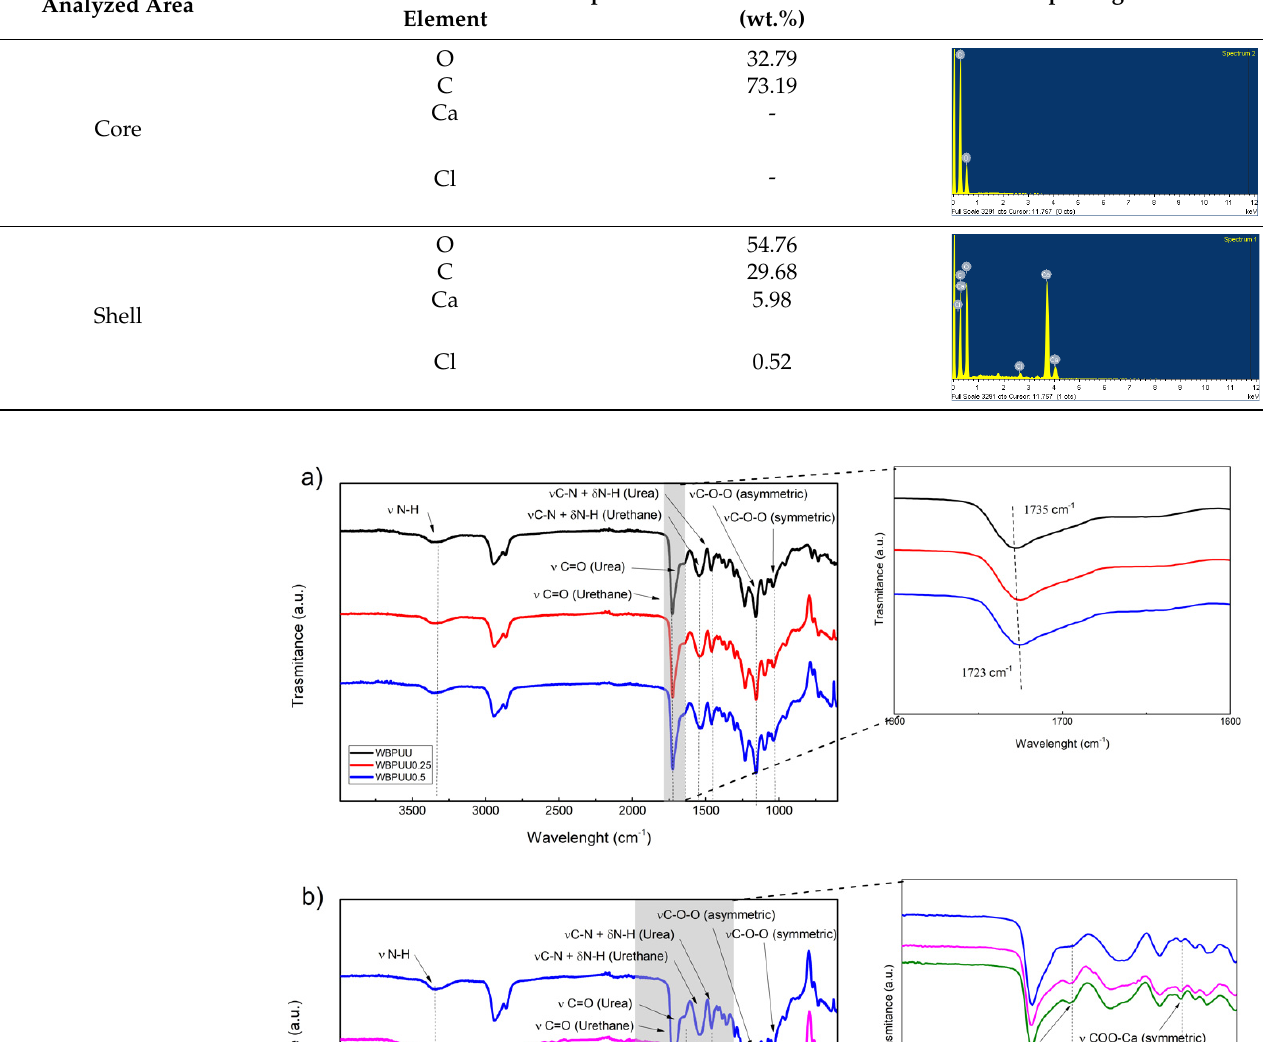
Table 2. Composition of the core and the shell of the WBPUU0.5Ca60 scaffold determined by EDS. Analyzed Area